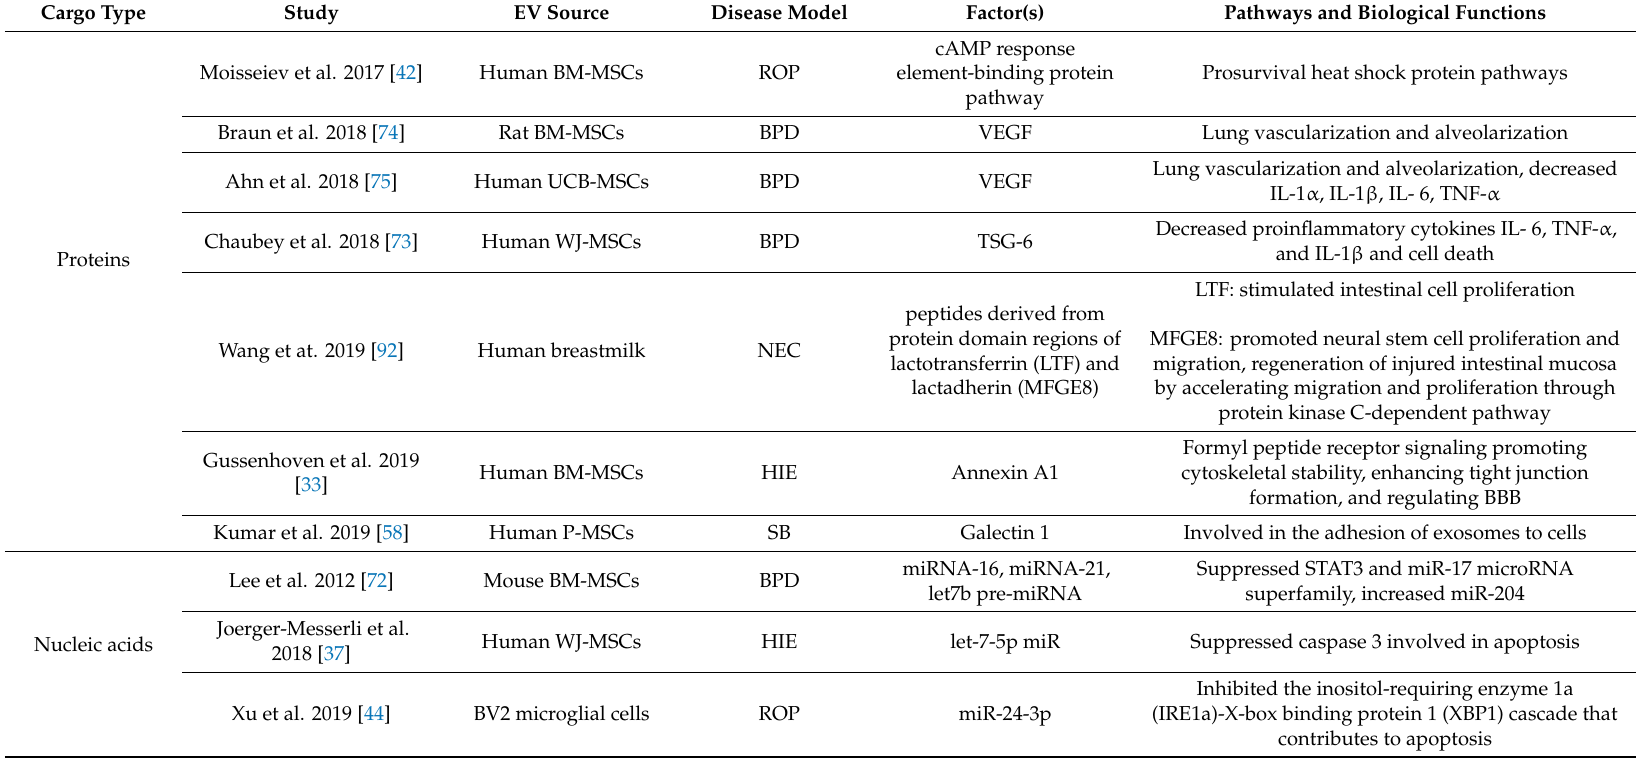
Table 2. Reported mediators of EV beneficial e ff